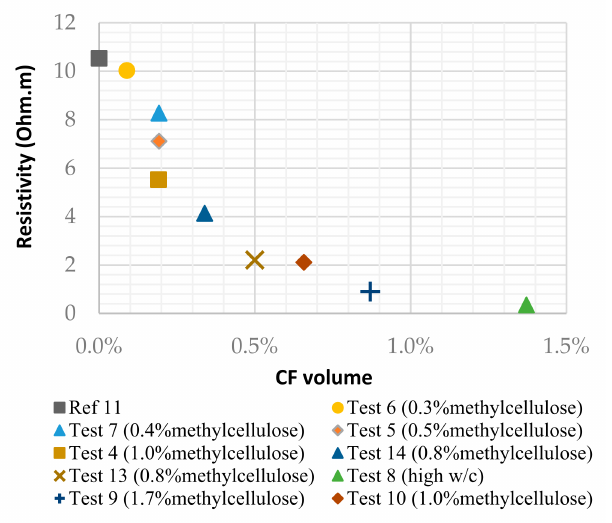
Figure 5. Resistivity of the cement-based solid electrolyte using different